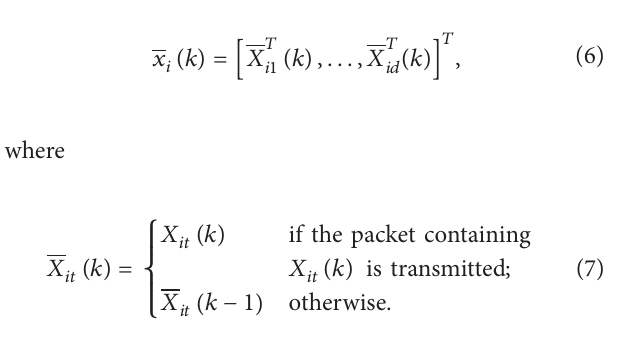
over a limited bandwidth communication channel.